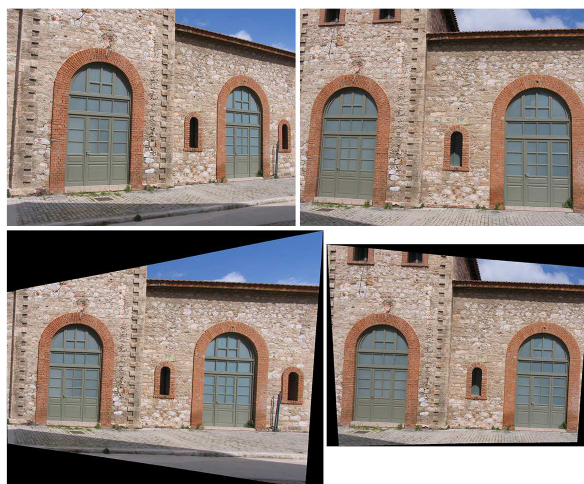
Figure 2. Top row: initial image pair (image axes convergence of 40º). Bottom row: automatically rectified images.